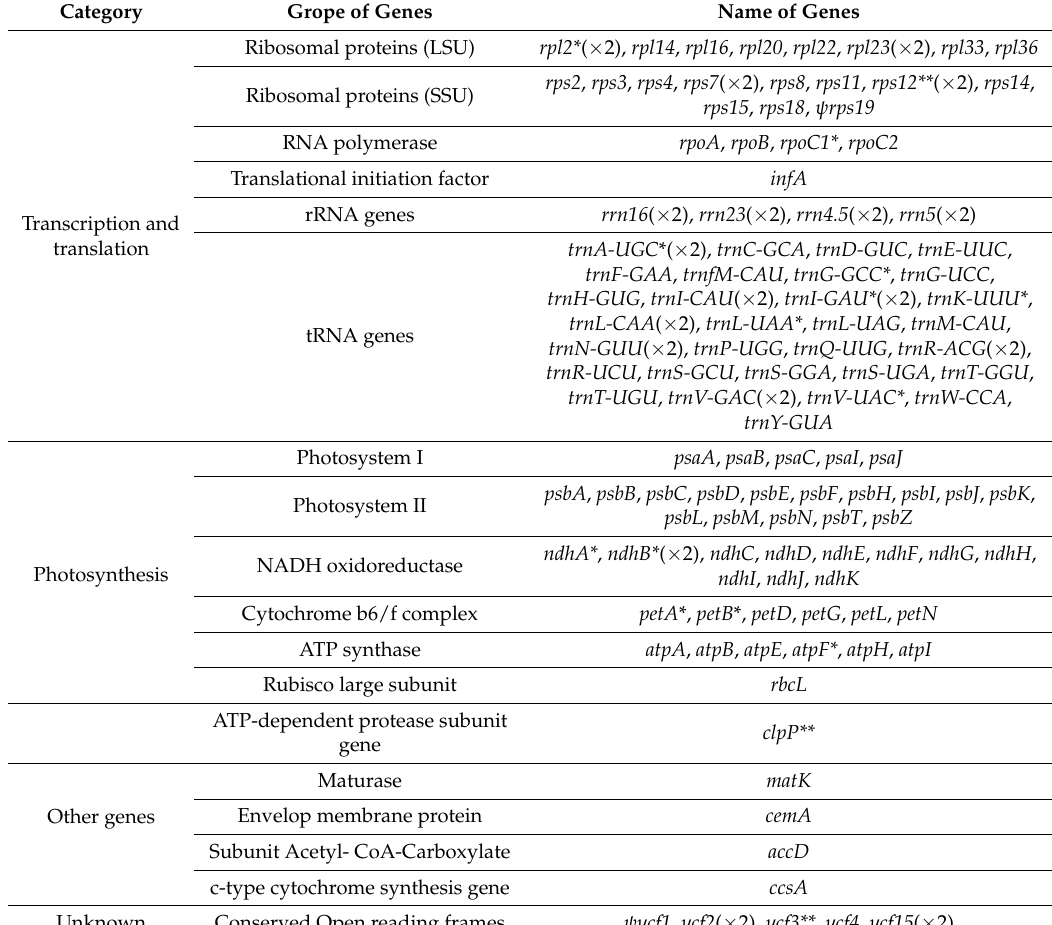
Table 2. A list of genes found in the chloroplast genomes of five Aconitum species.